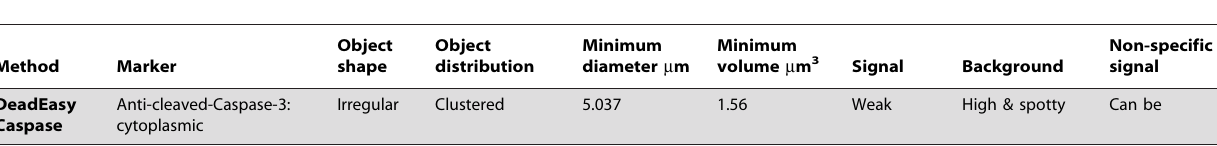
Table 1. Properties of cells counted by DeadEasy Caspase.